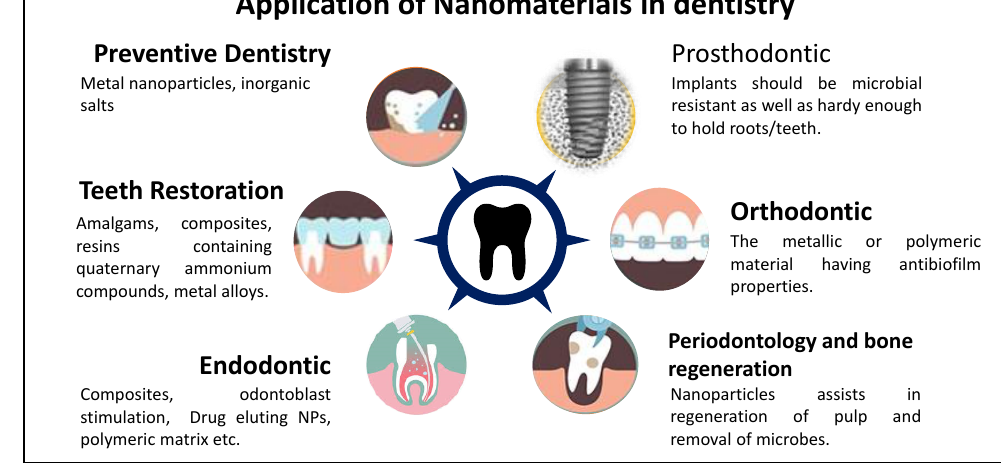
Figure 4. Pictorial representation of applications of nanomaterial in dentistry.